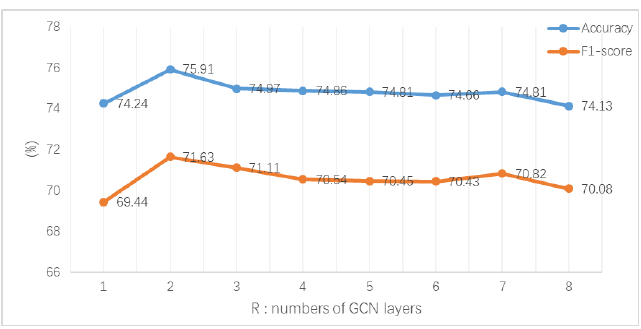
Figure 7. Impact of R over the lap14